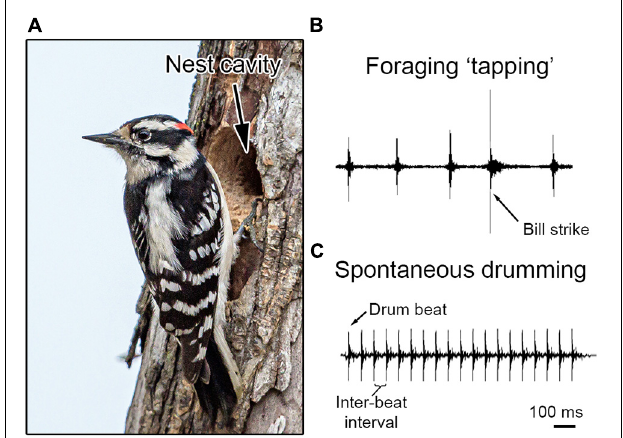
FIGURE 1 | Bill behaviors in the downy woodpecker ( Dyrobates pubescens ). (A) During the breeding season, downy woodpeckers excavate nest cavities within trees using their bill. These nest cavities serve as a place to raise offspring during the breeding season. Photo credit: Shiva Sheney (CC BY 2.0, no changes or modification were made to the photograph). (B) Throughout the year, woodpeckers will also use their bill to forage on trees for food, including probing for insects (see main text ). (C) Most woodpeckers communicate by hammering their bill repeatedly against a tree, which produces an acoustic signal used in courtship and competition. This loud atonal signal is called a “drum.” Each time the bill makes contact with the tree it produces a “drum beat,” with the timing between two beats called the inter-beat interval. Both recordings are at the same temporal scale for comparison, with a scale bar at the bottom